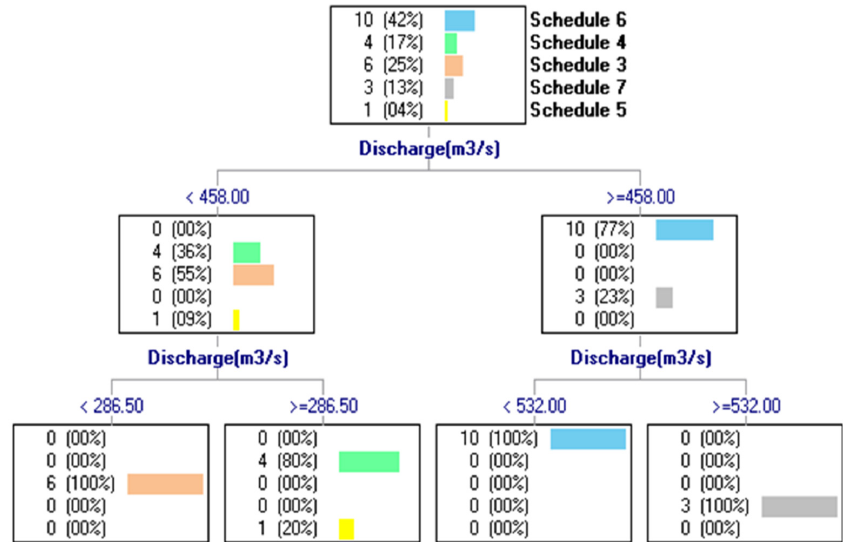
Figure 5. Decision tree of Tianshengqiao plant 1 generated by C4.5 for the winter season.